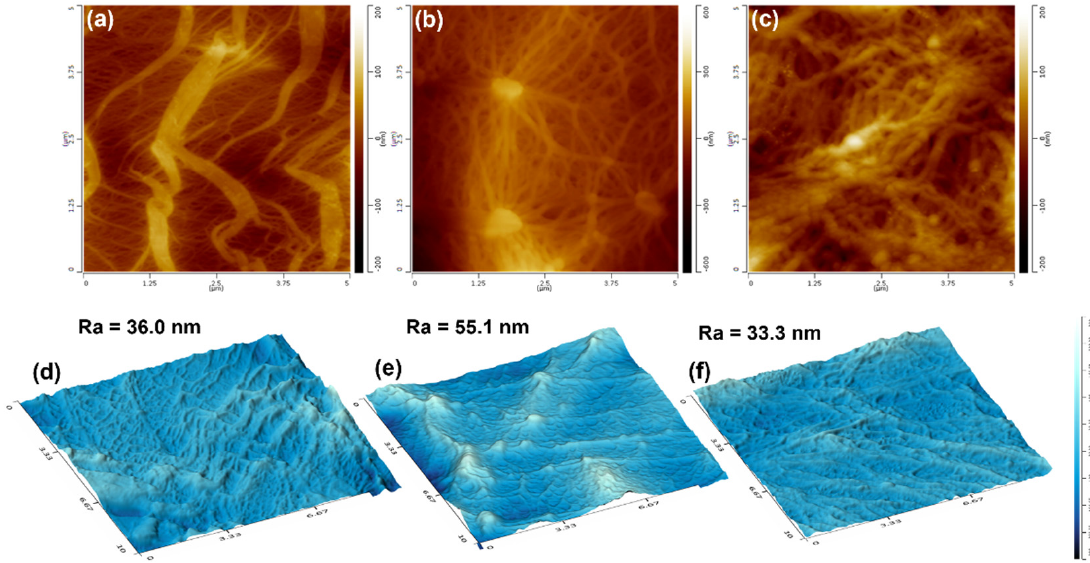
Figure 12. ( a – c ) AFM height images (5 μ m × 5 μ m) and ( d – f ) 3D AFM images (10 μ m × 10 μ m) of ( a ) β -PP, ( b ) PA6/PP(S), and ( c ) PA6/PP(F) microporous membranes. Ra represents the surface rough- ness of the microporous membranes.